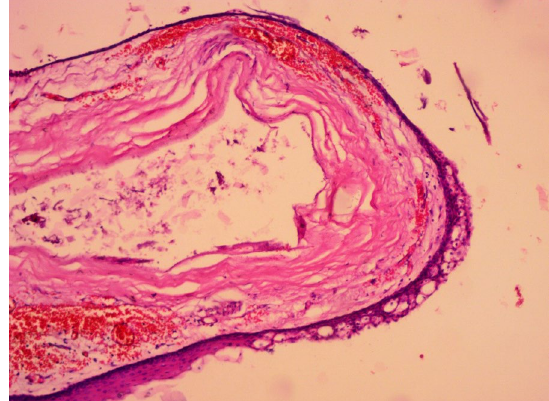
Fig. 5 The sections examined revealed strips of cyst wall lined by stratified squamous epithelium with orthokeratotic keratin and an intact granular layer, but devoid of